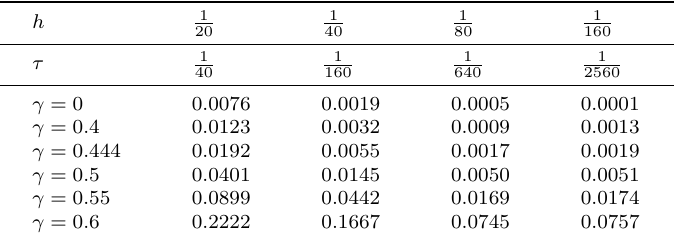
Table 3. The errors of solution in the case q ( x,y ) = 0, a = 1 . 5, T = 1; stability condition (4.3) is γ < 0 . 444. h 1